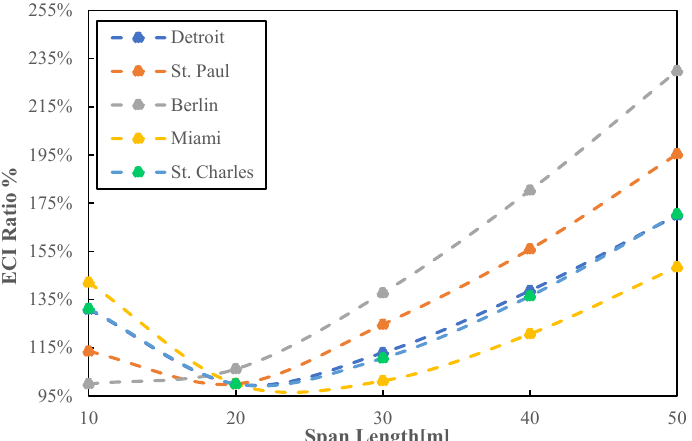
Figure 9. Average ECI ratio variation with span length for different load conditions.